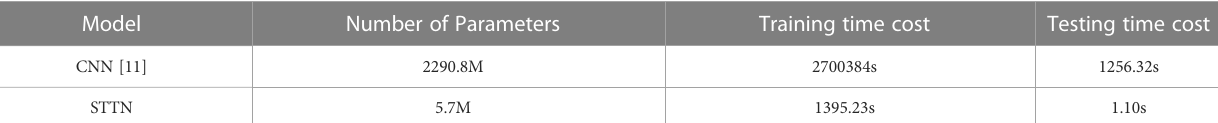
TABLE 5 Comparison of the computational costs required for different models.